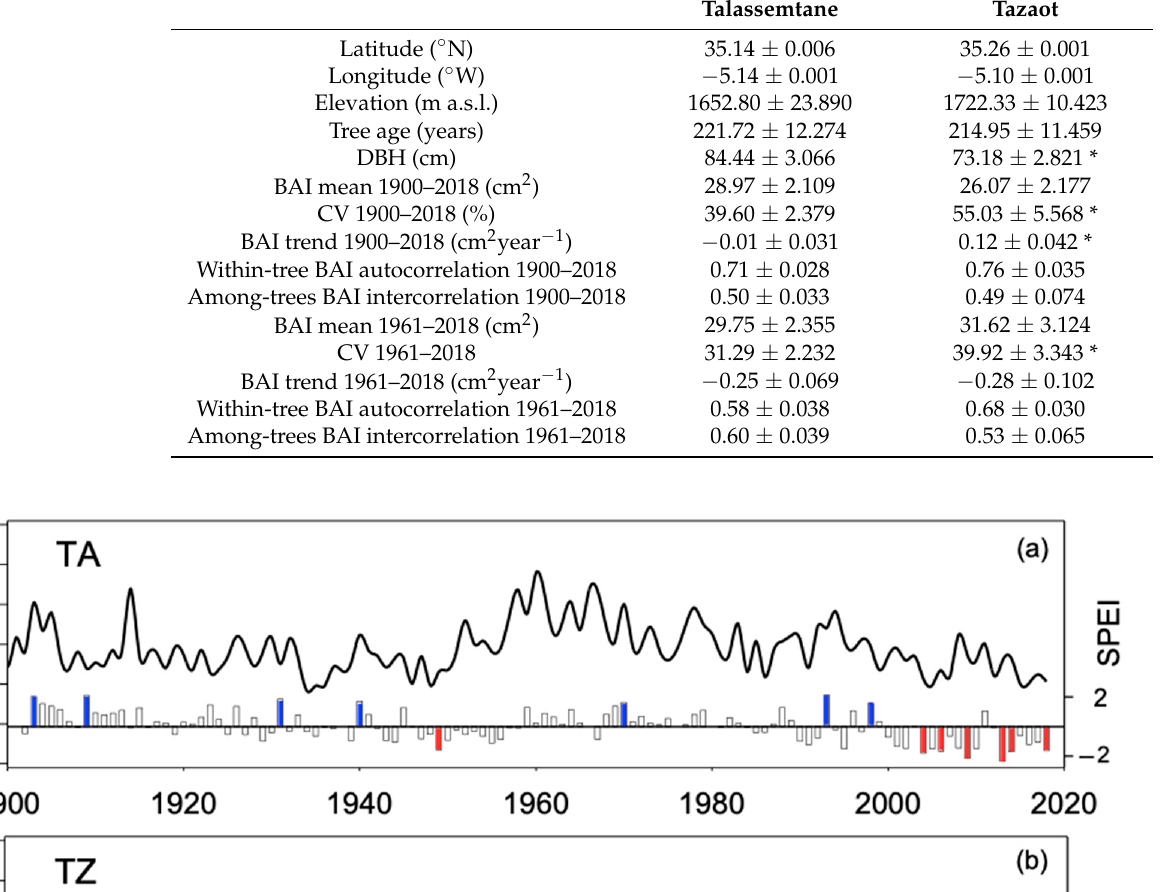
Table 2. Location and growth pattern estimated as the basal area increments (BAI) of tree rings obtained in Abies marocana for Talassemtane and Tazaot. Tree age was estimated at coring height, according to tree-ring dating. DBH indicates the tree diameter at 1.3 m from the ground. CV indicates the coefficient of variation, estimated as (100*) the ratio of the BAI standard deviation divided by the mean. BAI trend was estimated as the slope of BAI against the time. Within-tree BAI autocorrelation was estimated as the first-order correlation of the BAI ( i ) and the BAI ( i +1) . Among trees, BAI inter- correlation was estimated as the correlation of the individual BAI time series with the mean BAI time series. Values are mean ± standard error. * indicates significant differences (ANOVA, p < 0.05). Talassemtane Tazaot Latitude ( ◦ N) 35.14 ± 0.006 35.26 ± 0.001